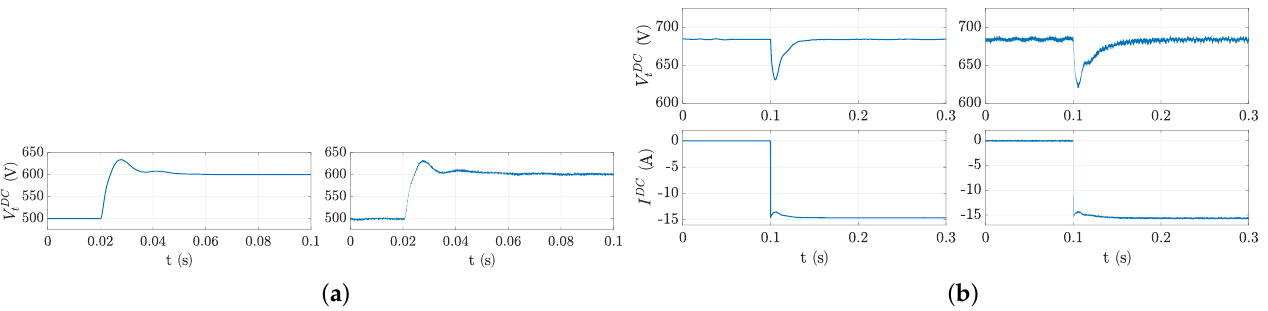
Figure 16. Simulation ( left ) and experimental ( right ) results, ( a ) showing the DC link voltage during a step change from 500 V to 600 V. ( b ) showing the DC voltage and current when a R equivalent to rated power (10 kW) is